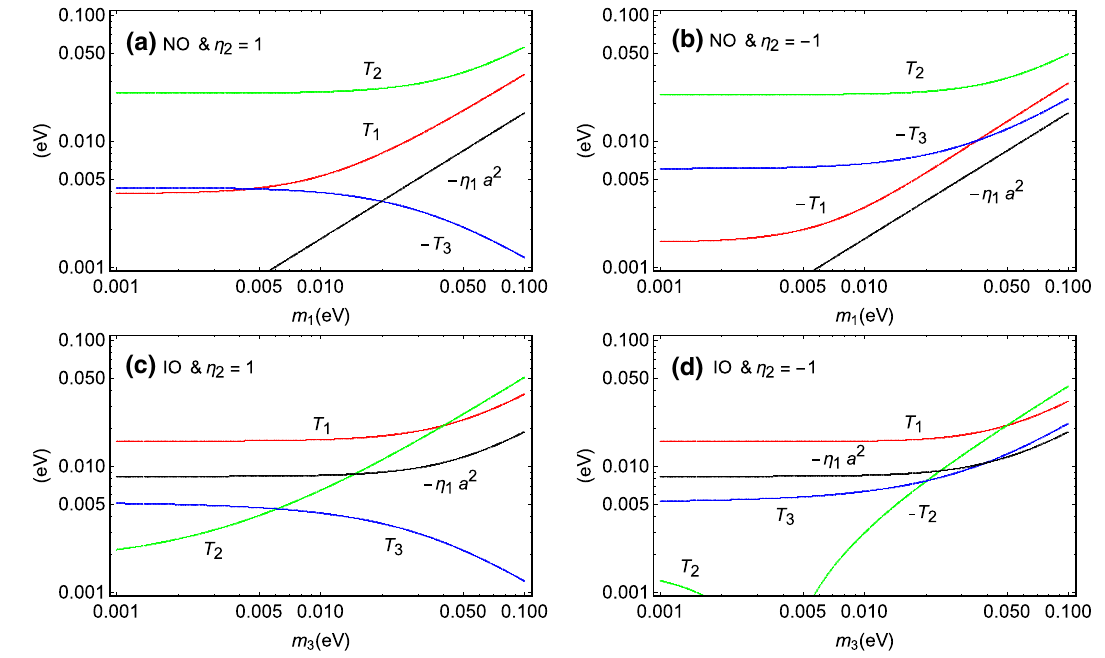
, T and T as functions of the lightest neutrino mass in the NO 1 2 3